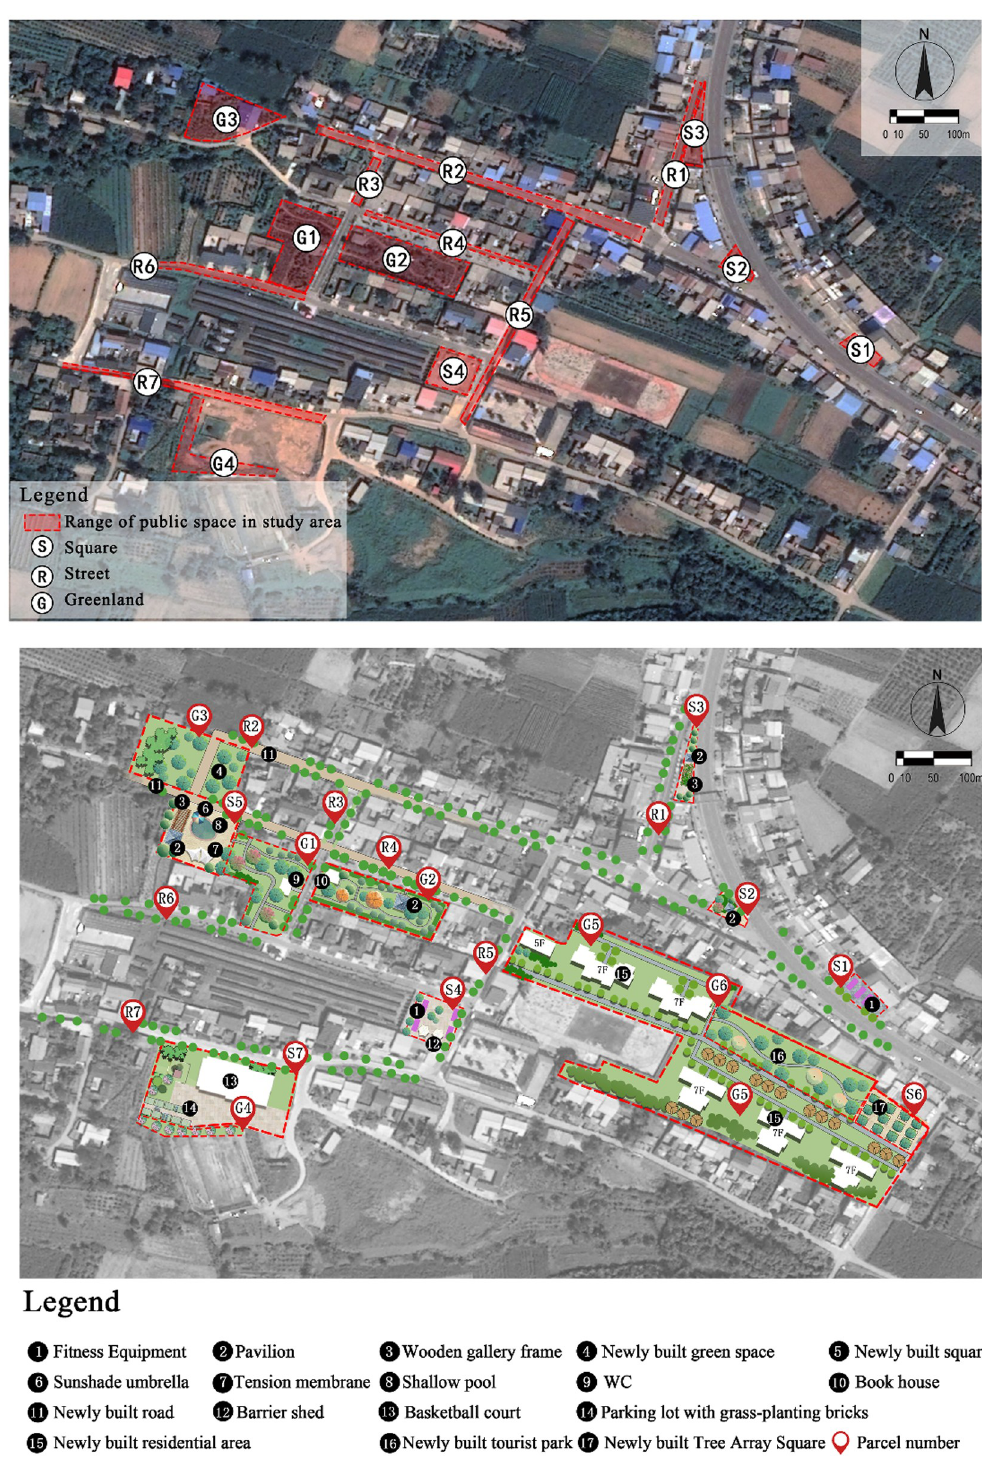
Fig 18. (a) Current map of the village’s public spaces. (b) Thermal-comfort plan of the village’s public spaces. (The satellite images in Fig 18(a) and 18(b) with permission from Beijing Qianfan Shijing Co., Ltd, original copyright [2020] [96]).